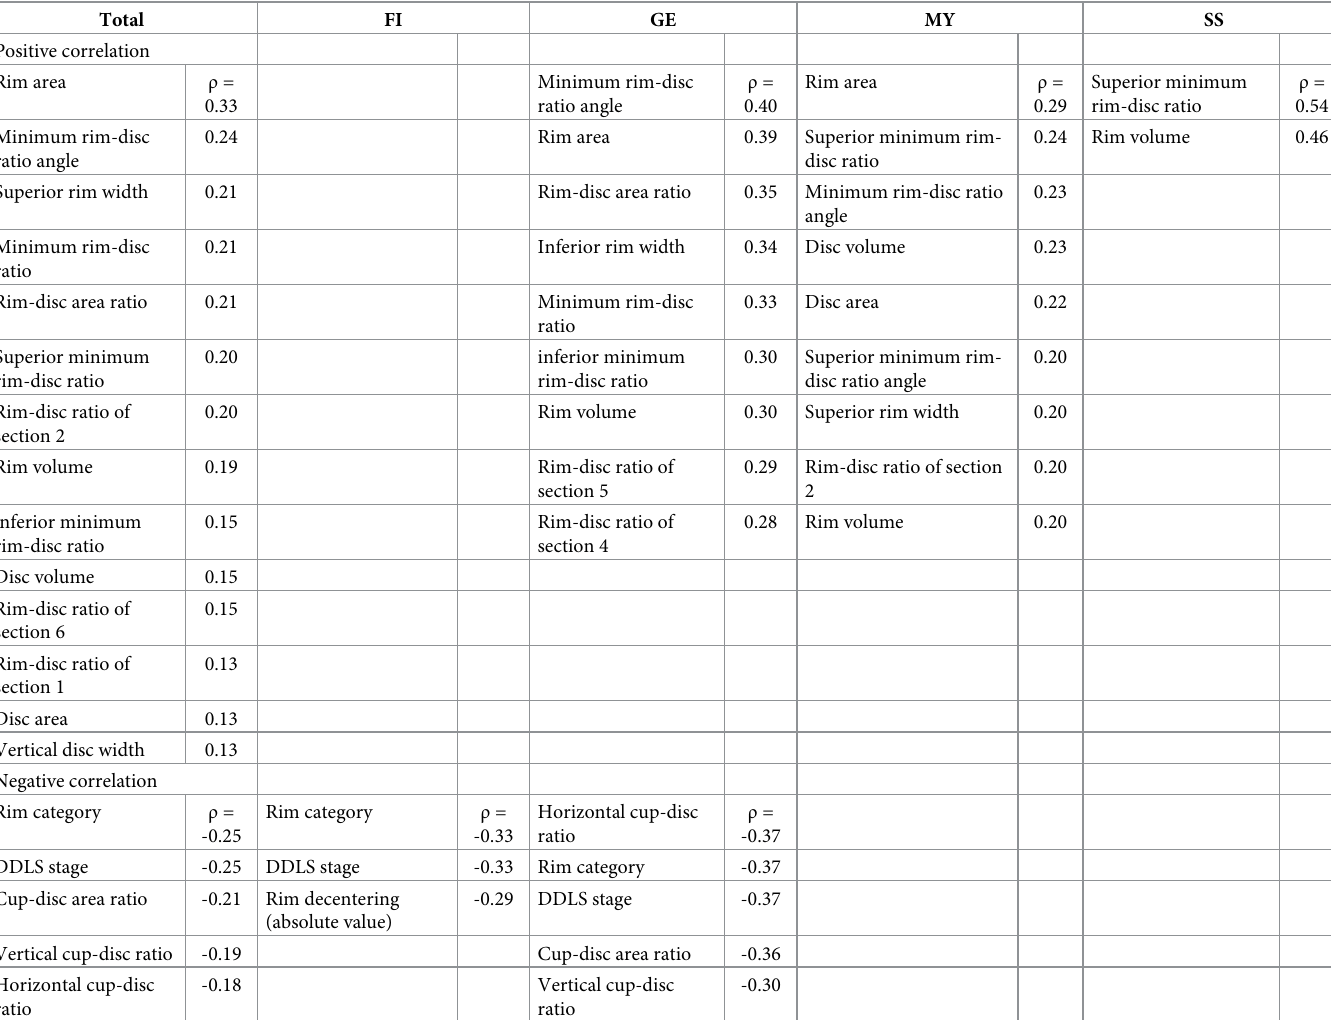
Table 5. Parameters significantly correlated with CRAE (sorted by effect